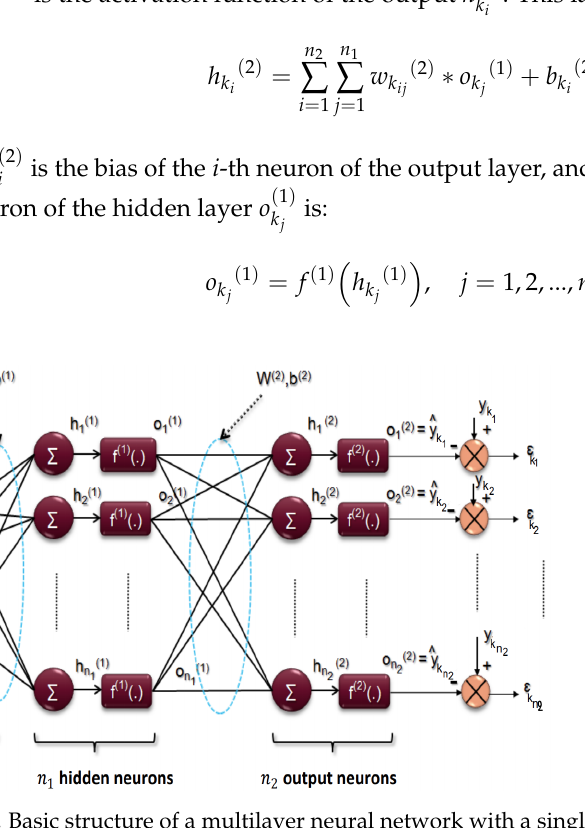
Figure 1. Basic structure of a multilayer neural network with a single hidden